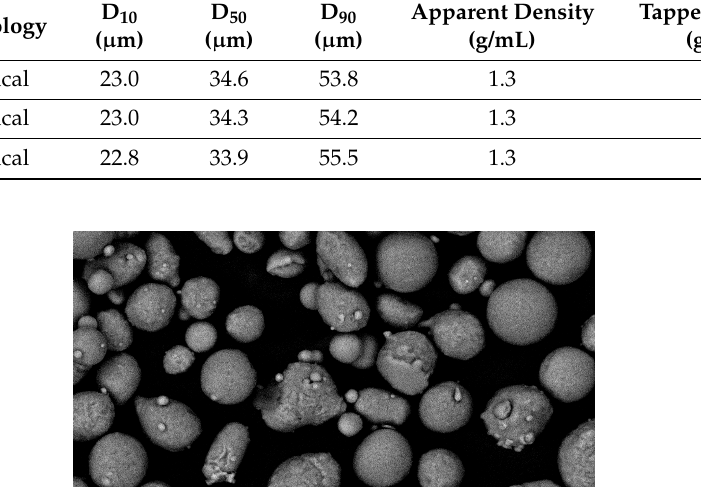
Figure 6. BSE image of high oxygen Al powder.